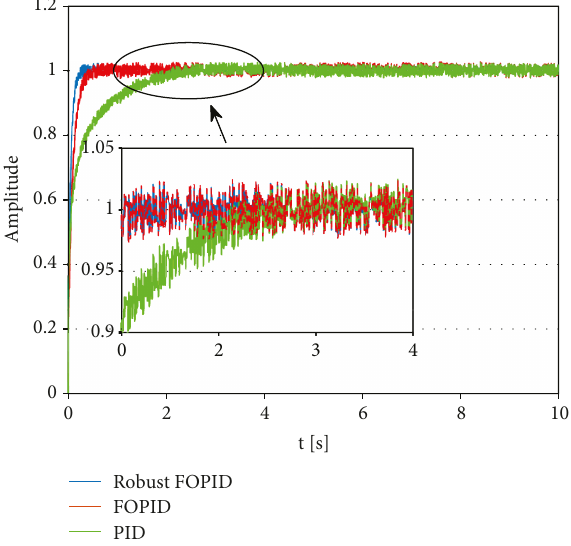
Figure 13: Step response comparison of G s with noise input. Figure 15: Step response comparison of G 2 s with disturbance. 2